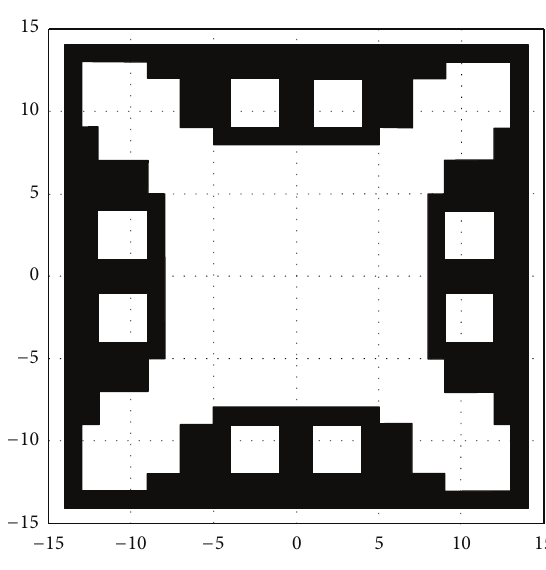
Figure 8: Reflection